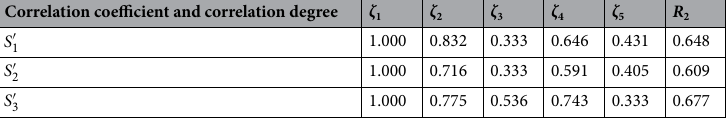
Table 7. Correlation with the second-level air